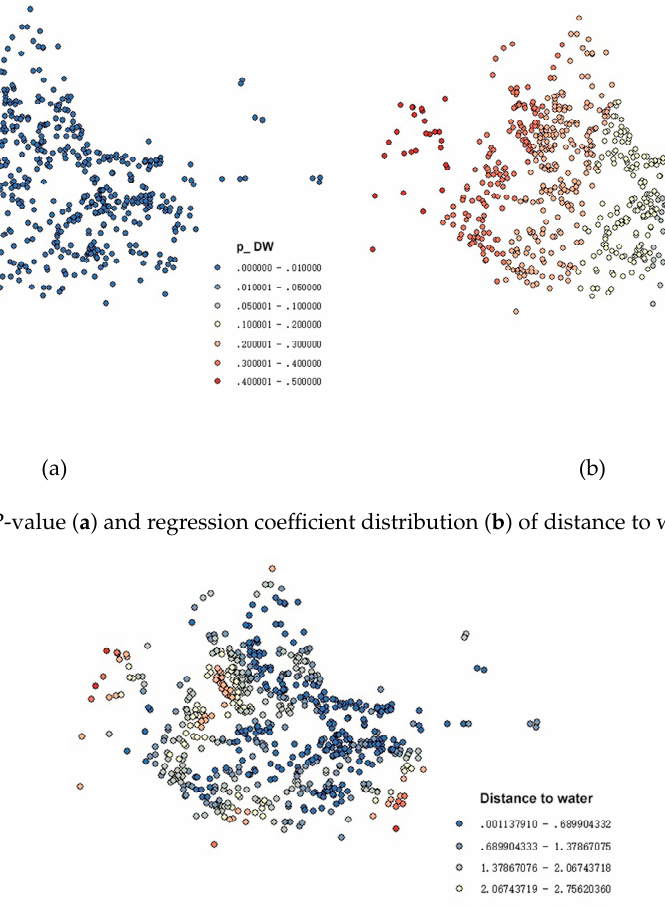
Figure 3. P-value ( a ) and regression coefficient distribution ( b ) of distance to water system.